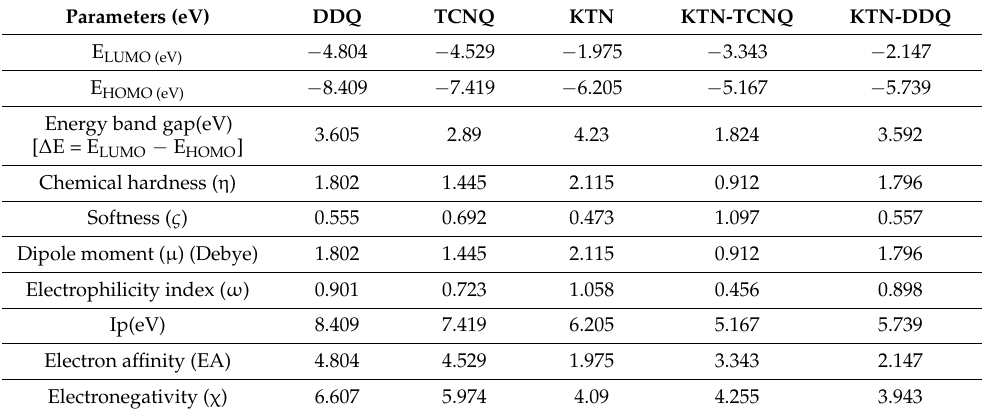
Figure 6. The assignments of theoretical electronic absorption transitions of ( A ) KT-DDQ and ( B ) KT-DDQ charge transfer complexes. Table 5. The electronic reactivity descriptors of the KT, DDQ, TCNQ, KT-TCNQ, and KT-DDQ.